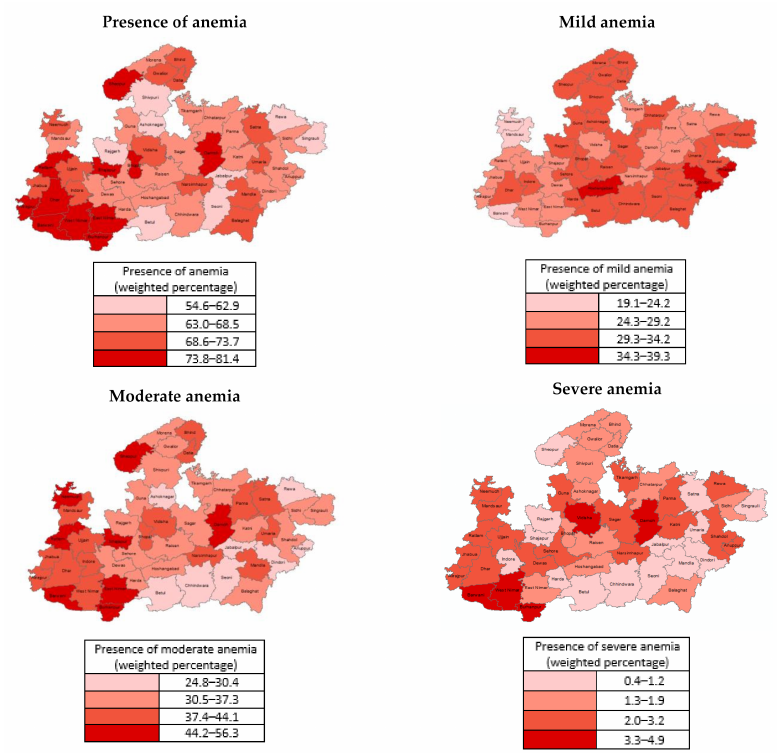
Figure 1. Spatial distribution of anemic children in Madhya Pradesh at the